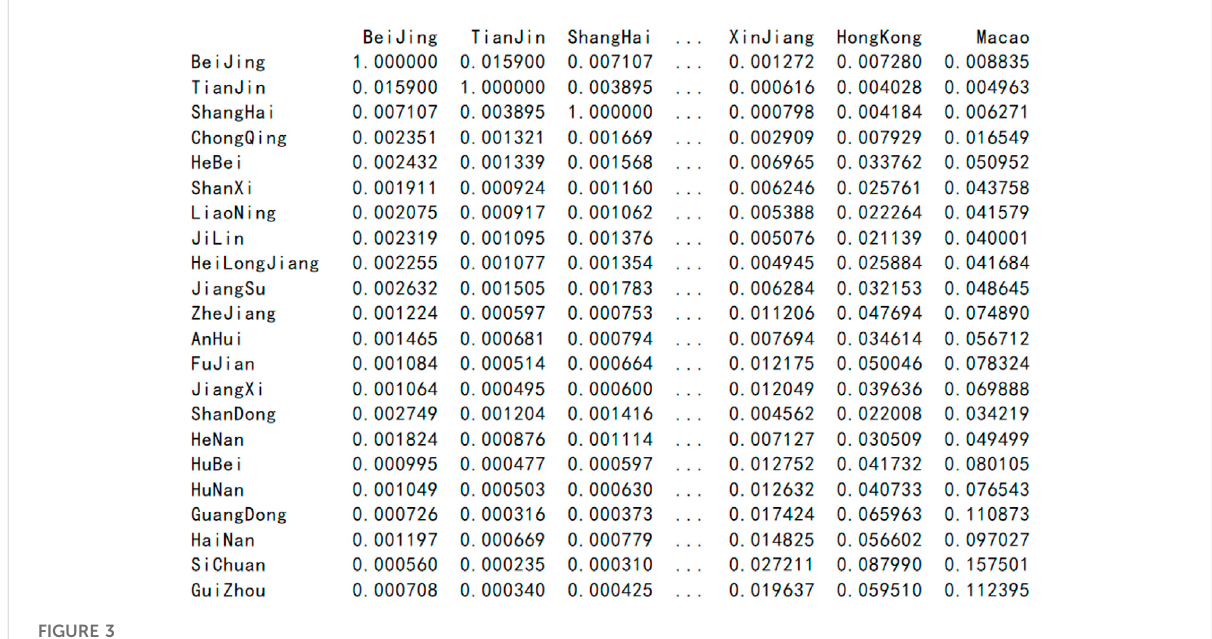
FIGURE 3 Screenshot of a part of the adjacency